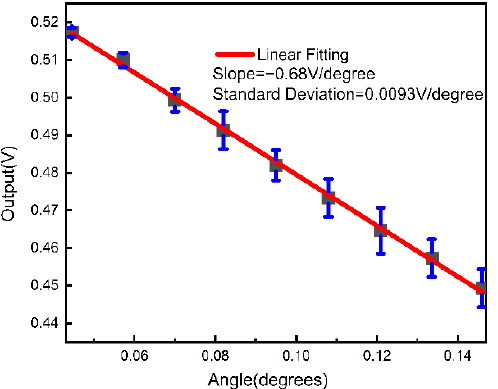
Figure 11. Linear fitting between transmitted intensity and the input pitch angle within a range from 0.04° to 0.15°. The experiment was repeated three times. The black dots show the average value of experimental results.